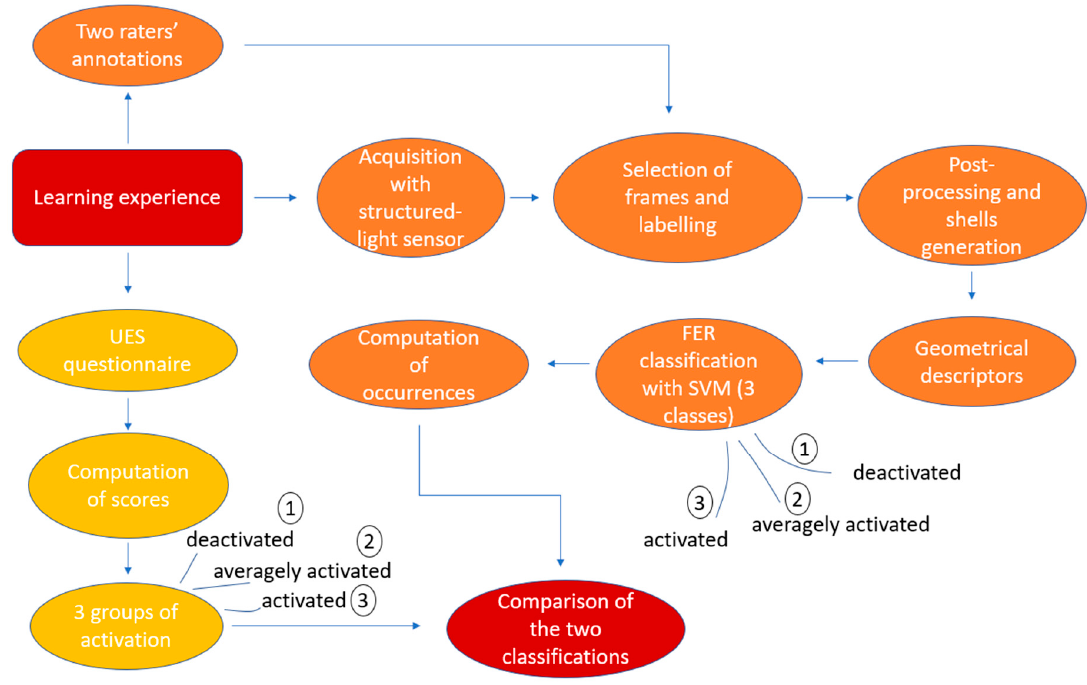
Figure 6. Schematization of the proposed methodology. The two parallel methods of evaluation of engagement are highlighted with different colors: orange (facial analysis and support vector machine (SVM) classification) and yellow (self-report evaluation). The red blocks represent the starting point of our evaluation (the learning experience) and the focus of our work (the comparison of the two classifications, i.e., the comparison of the results coming to light from the questionnaires and from the facial expression recognition (FER) methodology).